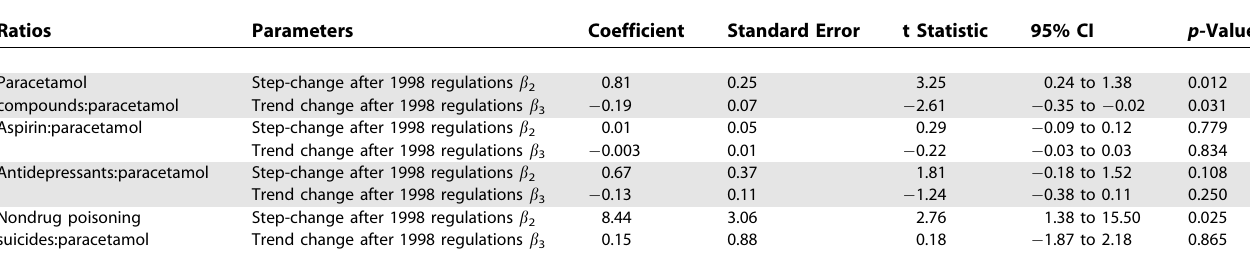
Table 4. Interrupted Time-Series Regression Analysis of the Ratio of Age-Standardised Poisoning Mortality Rates for Paracetamol Compounds, Antidepressants, and Nondrug Poisoning Suicide:Paracetamol